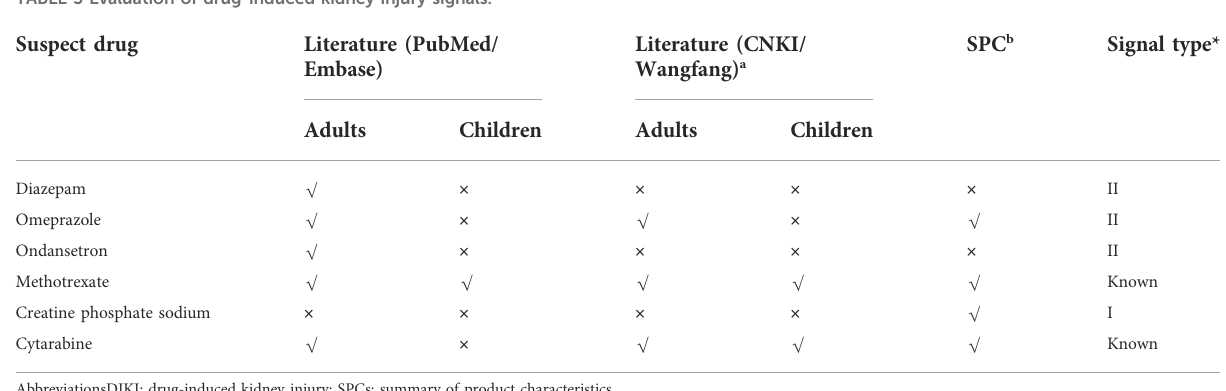
TABLE 3 Evaluation of drug-induced kidney injury